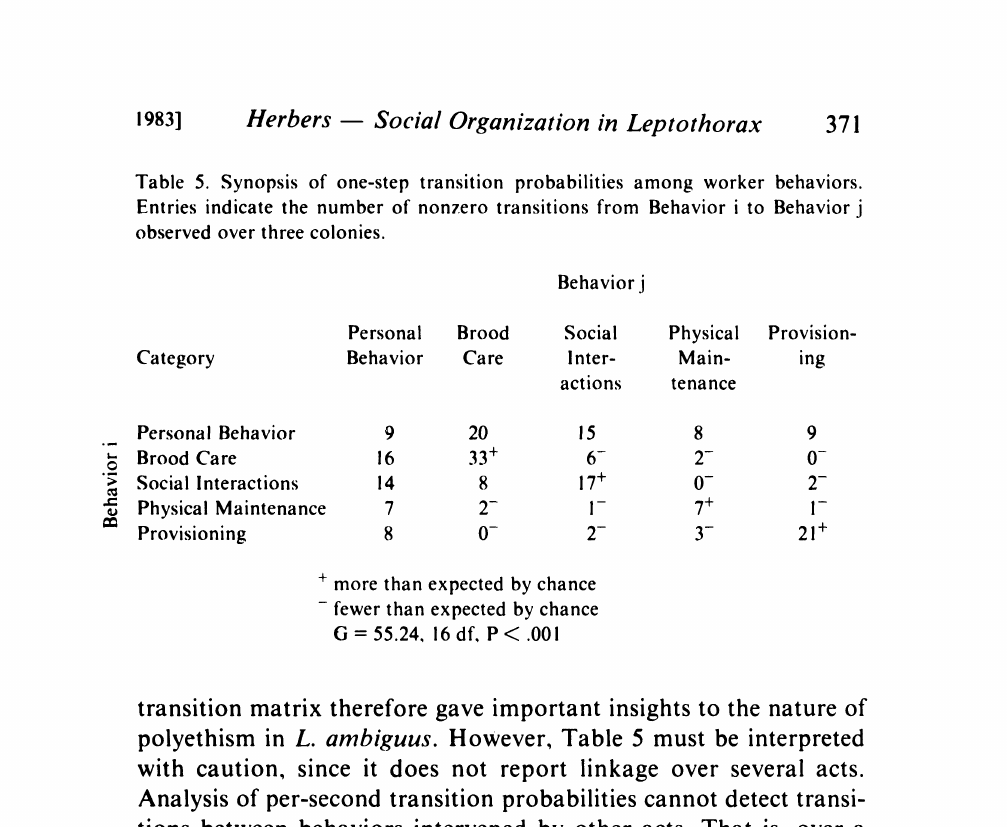
Table 5. Synopsis of one-step transition probabilities among worker behaviors. Entries indicate the number of nonzero transitions from Behavior to Behavior observed over three